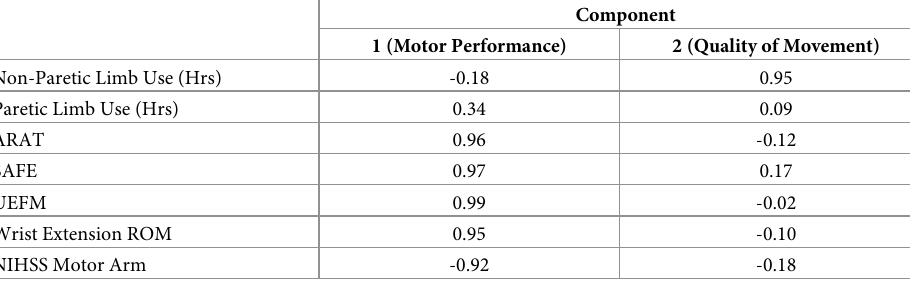
Table 4. Item loadings based on two-factor solution with oblique